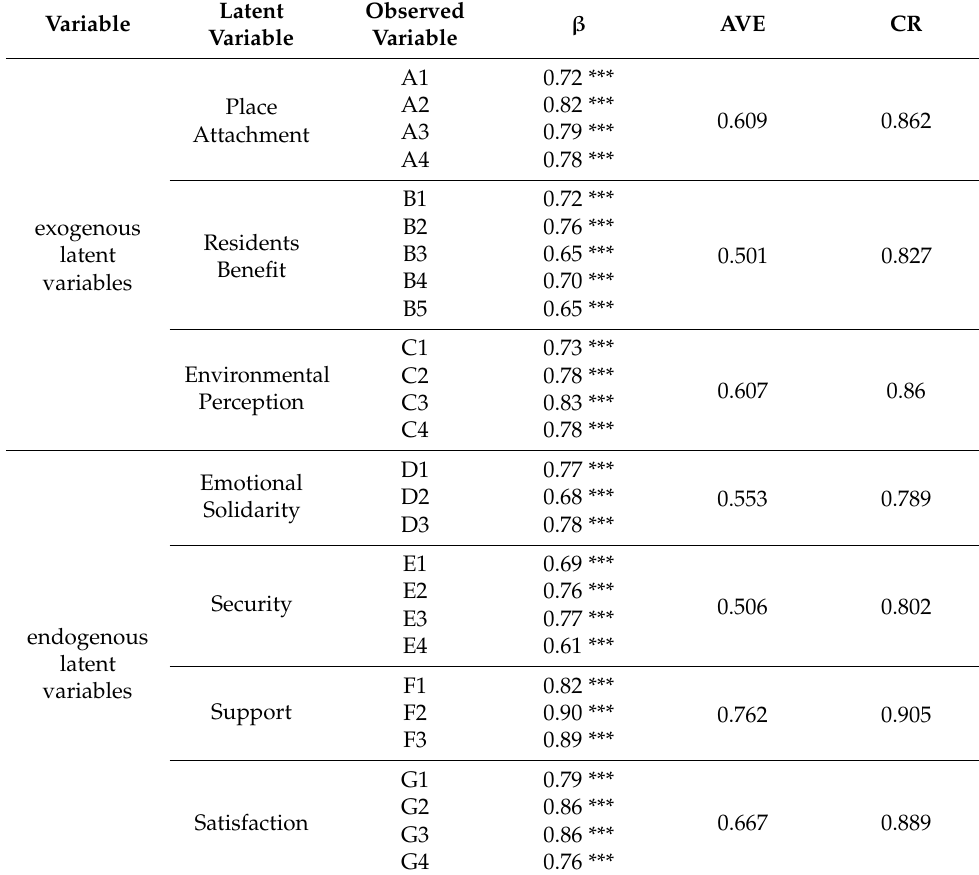
Table 2. Validation factor analysis.